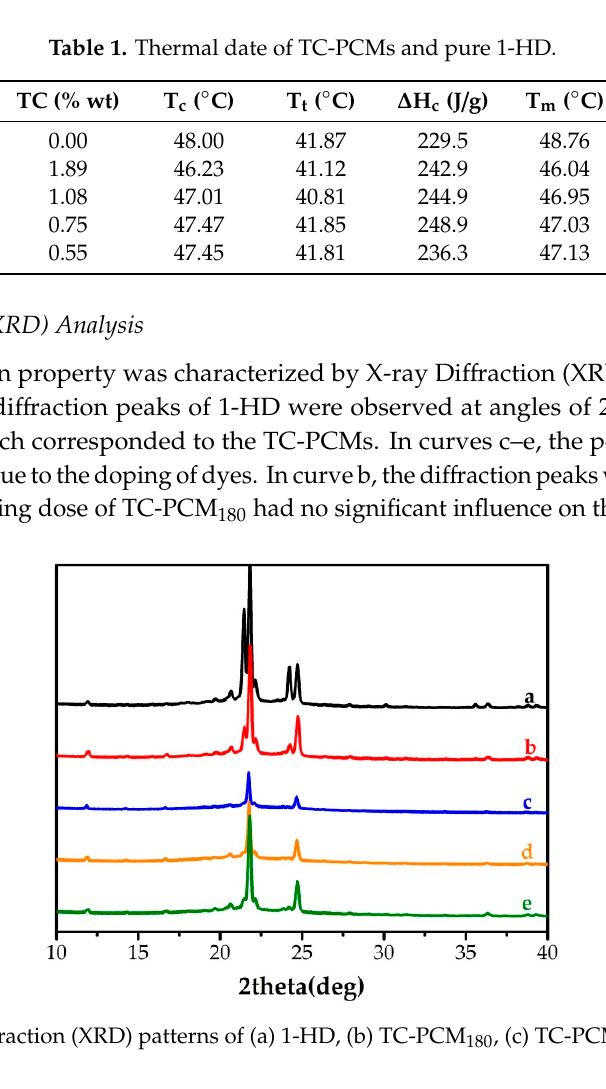
Table 1. Thermal date of TC-PCMs and pure 1-HD.